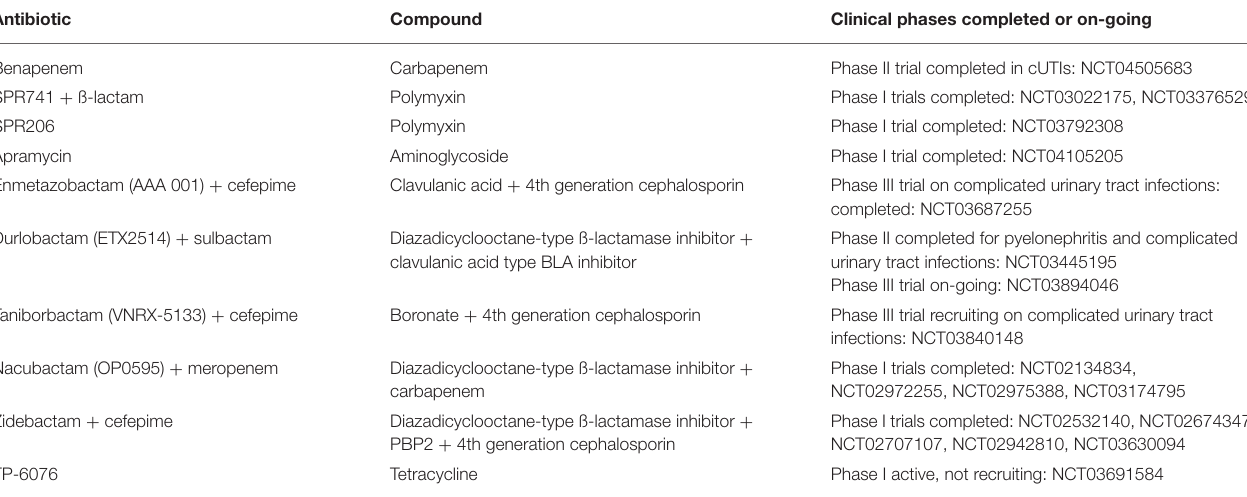
TABLE 2 | Intravenous antibiotics active in-vitro against gram-negative bacteria in phase I-III studies (19). Antibiotic